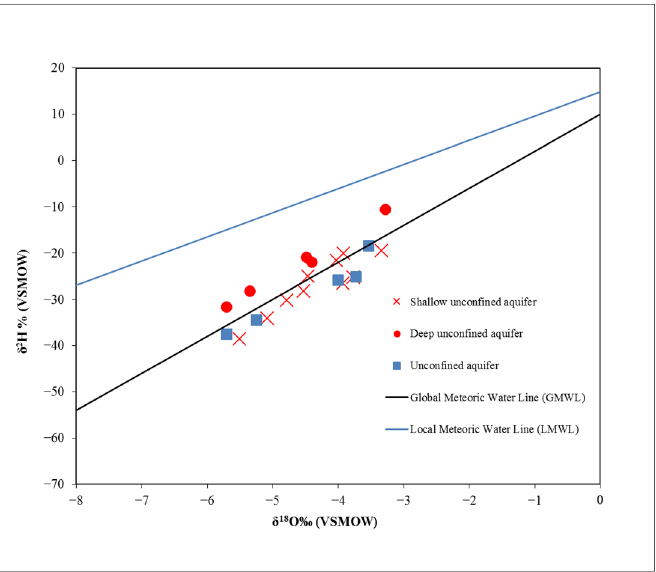
Figure 12. δ 18 O and δ 2 H ratios of tested groundwater from unconfined and confined sections of the Wajid aquifer.